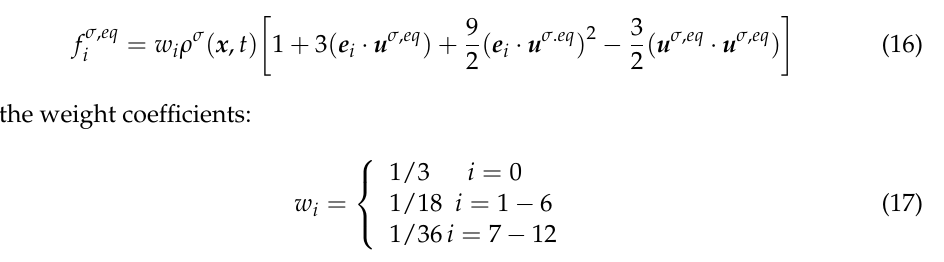
Figure 1. Discrete velocities of D3Q19 model.